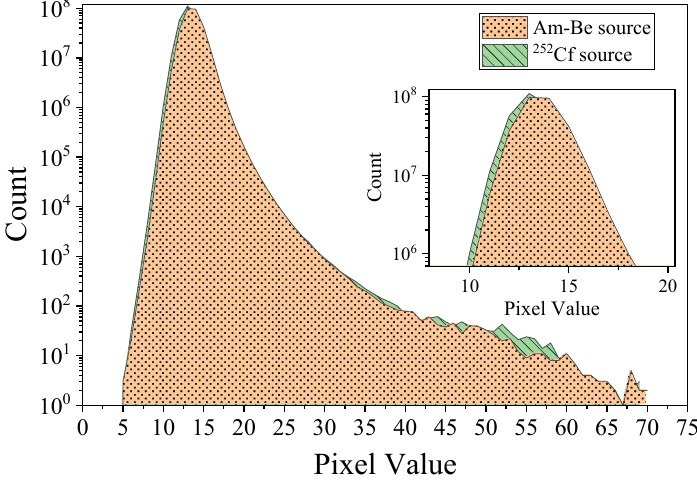
Figure 3. Histogram of Am-Be and 252 Cf source radiation signals of the sensor.